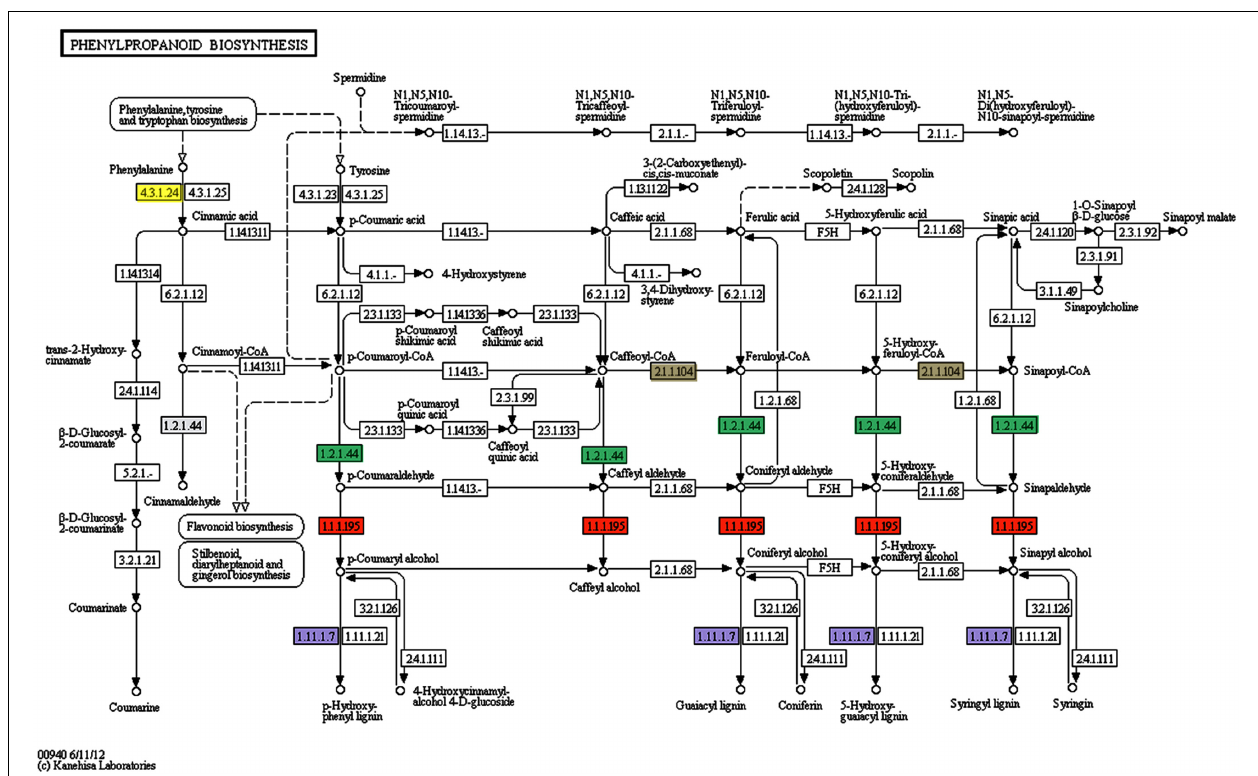
FIGURE 3 | Patway map from KEGG for the phenylpropanoid biosynthesis pathway. Several genes involved in this pathway have been found to be induced in olive roots (Schilirò et al., 2012) and/or aerial tissues (this study) upon Pseudomonas fluorescens PICF7 root inoculation. The enzymes reductase (1.2.1.44) (green rectangles) induced in aerial tissues, the cinnamyl-alcohol deydrogenase (1.1.1.95) (orange rectangles), the lactoperoxidase (1.11.1.7) (violet rectangles), the phenylalanine ammonia-lyase (4.3.1.5) ∗ induced in roots and aerial